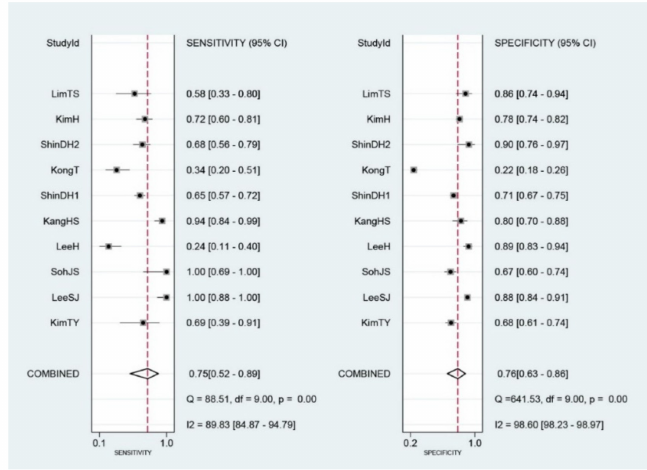
Figure 3. Forest plots of sensitivity and specificity of initial Delta neurophil index (DNI) for the prediction of poor prognosis in gastrointestinal diseases. The diamond indicates the combined estimate from the included studies.